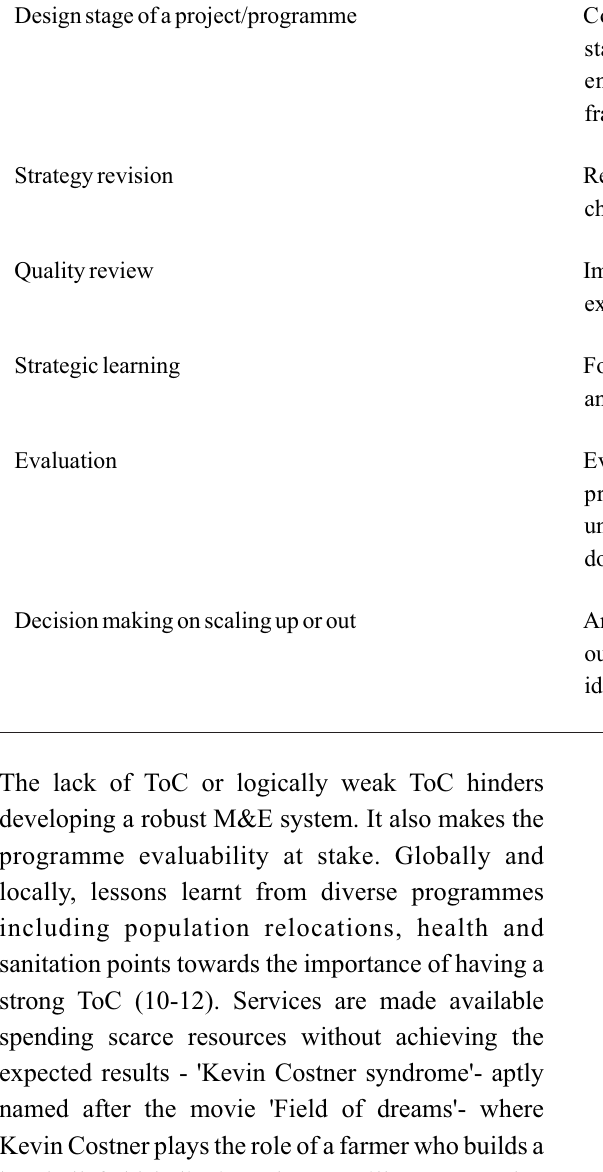
Table 1: Practical application of ToC Design stage of a project/programme Comprehensive situation analysis (problem analysis, stakeholder analysis and strategy analysis),